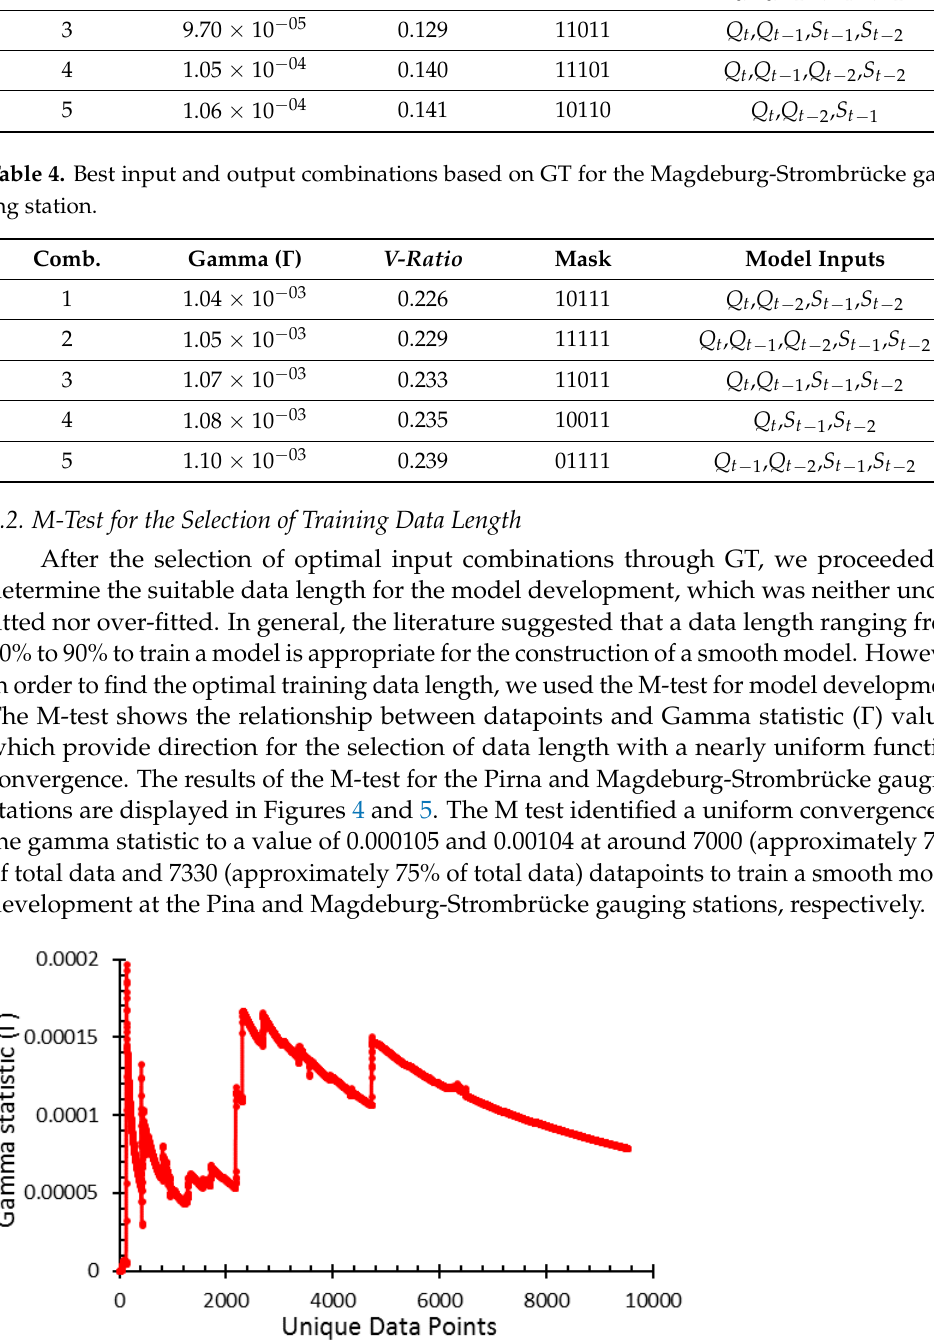
Figure 4. M-test graph for the Pirna gauging station data length.